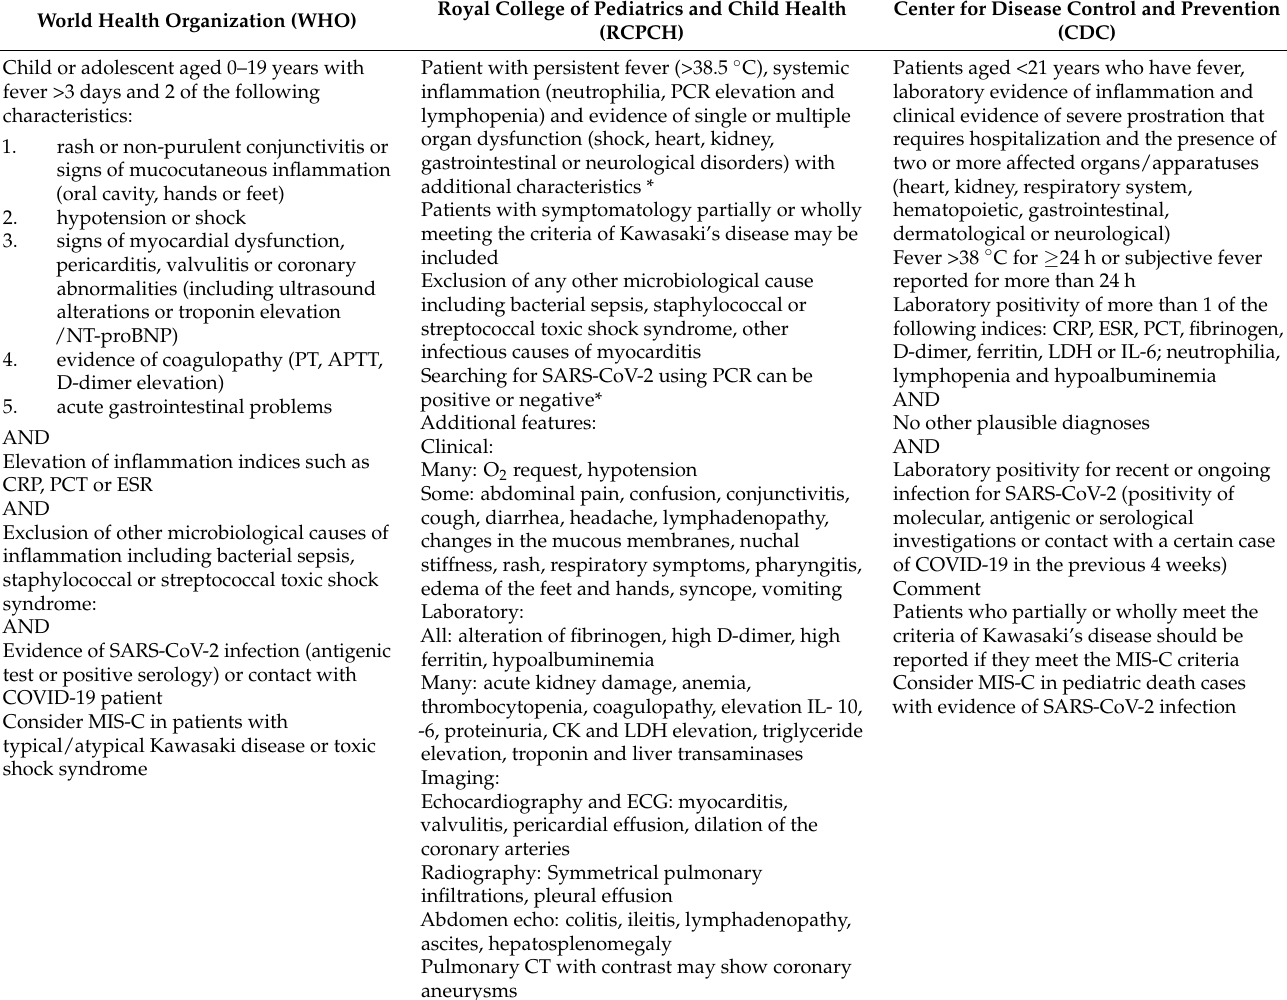
Table 3. Multisystemic inflammatory syndrome (MIS-C)